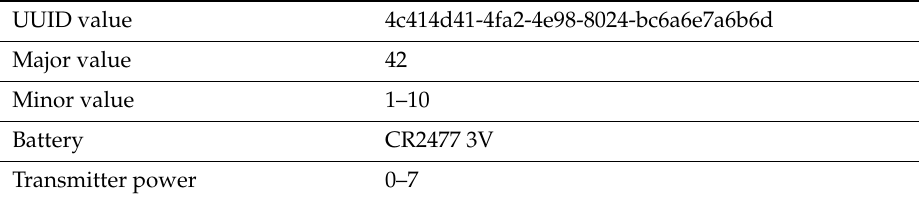
Figure 12. The smart beacon. Table 1. The configuration of the transmitters.